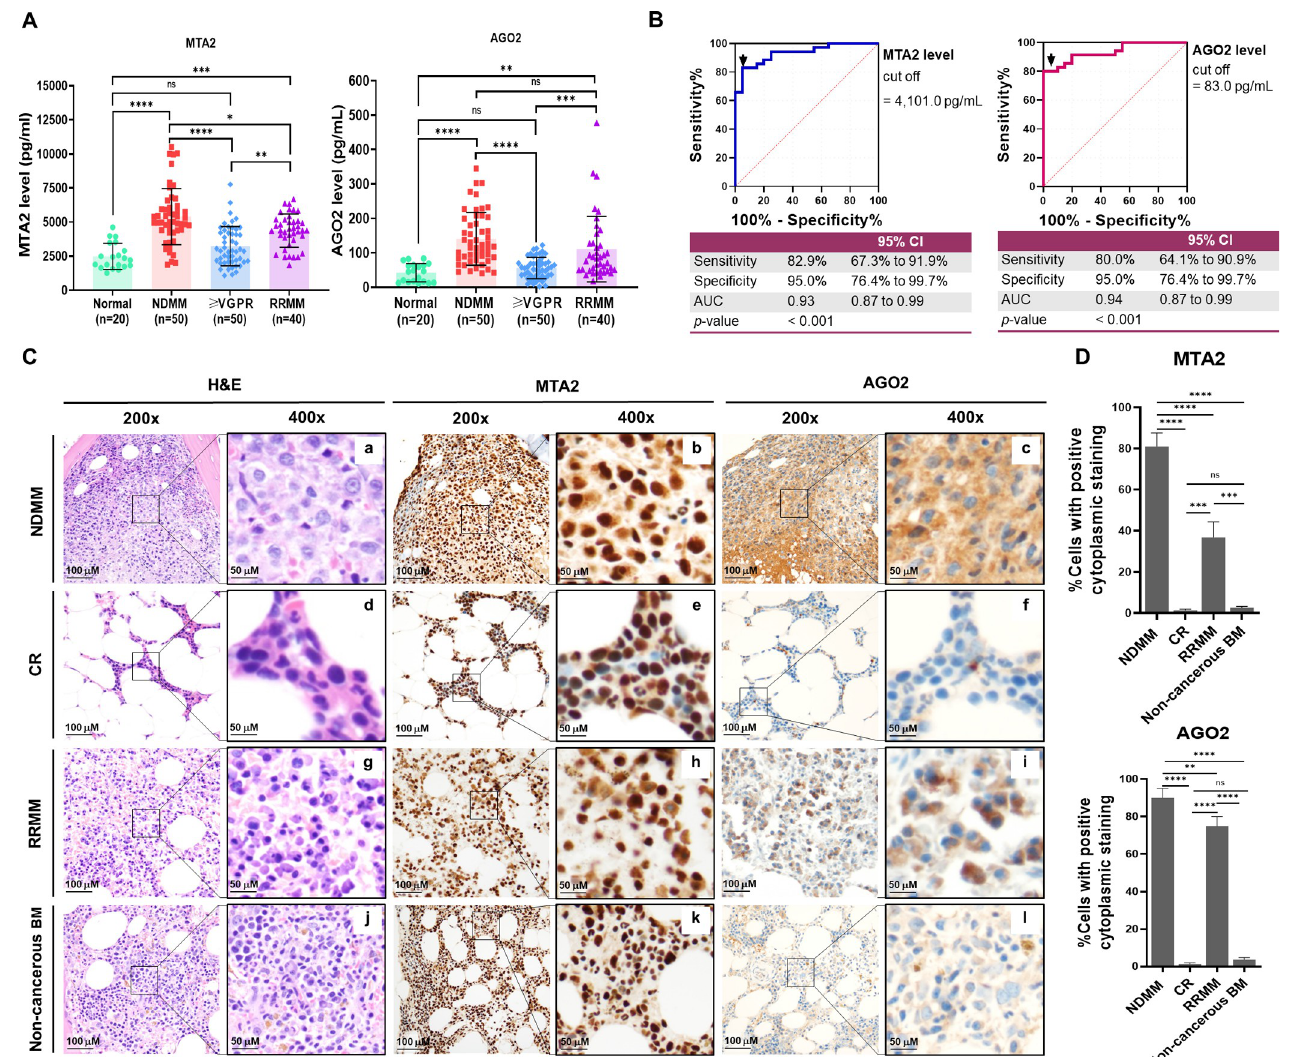
Fig 4. Measuring MTA2 and AGO2 levels in the verification phase. (A) Comparison of serum MTA2 and AGO2 levels among normal control, NDMM, � VGPR and RRMM groups (B) The ROC analysis demonstrated the diagnostic performance and provided a specific cut-off for serum MTA2 and AGO2. (C) Protein expression levels of MTA2 and AGO2 by IHC staining in representative NDMM, CR, RRMM and non-cancerous BM core biopsies. The MTA2 protein was localized in the nucleus of all leukocytes (panels e and k, 400x), which was considered an internal positive control. In NDMM and RRMM, MTA2 protein was localized in both the nucleus and cytoplasm of myeloma cells (panels b and h, 400x). The AGO2 protein was mainly localized in the cytoplasm of myeloma cells, especially in NDMM and RRMM (panels c and i, 400x). (D) Relative expressions of MTA2 and AGO2 by IHC in NDMM, CR, RRMM and non- cancerous BM core biopsies. � represents p < 0.05, �� represents p < 0.01, ��� represents p < 0.001, ���� represents p < 0.0001 and ns represents not